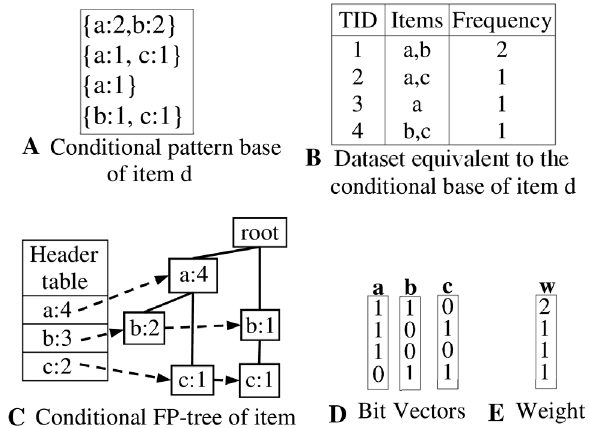
Figure 4. Illustration of FP-Tree and Bit Vector Construction. A: Conditional pattern base of item d; B: Dataset equivalent to the conditional base of item d; C: Conditional FP-tree of item d; D: Bit Vectors; E: Weight